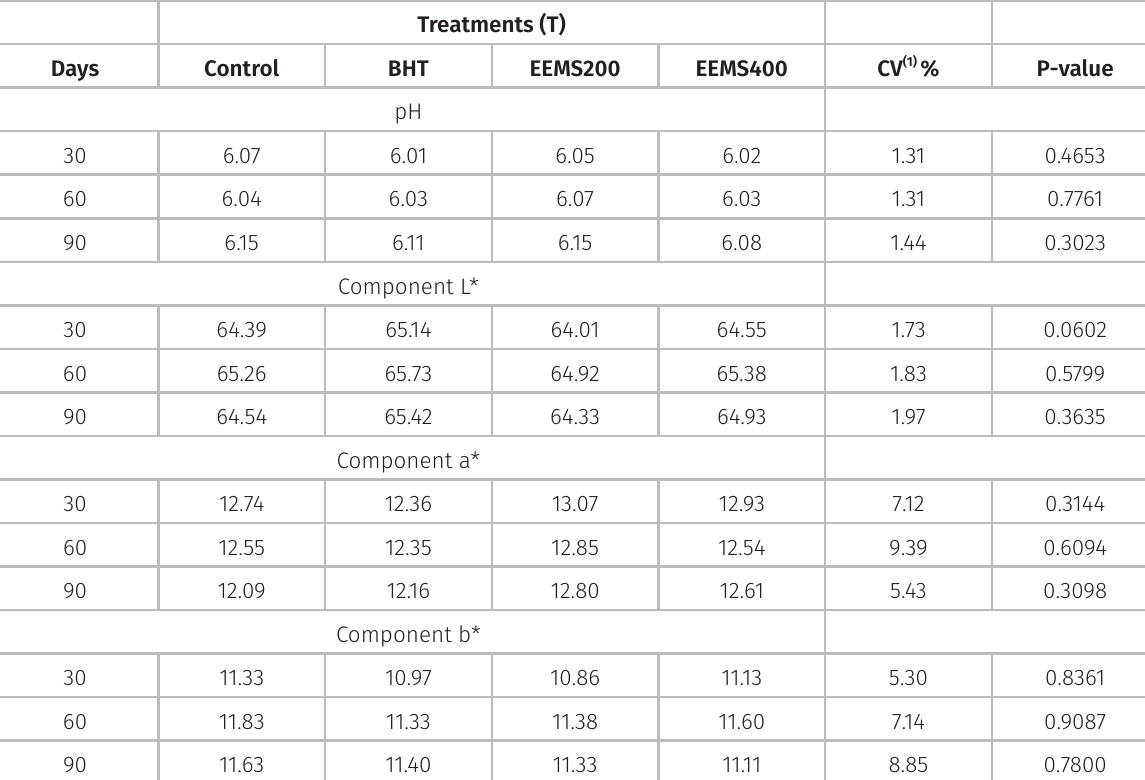
Table III. PH value, light intensity (L *), red intensity (a *) and yellow intensity (b *) of bologna prepared with pork meat fed with diets containing BHT and EEMS stored under refrigeration at 4 °C for 90